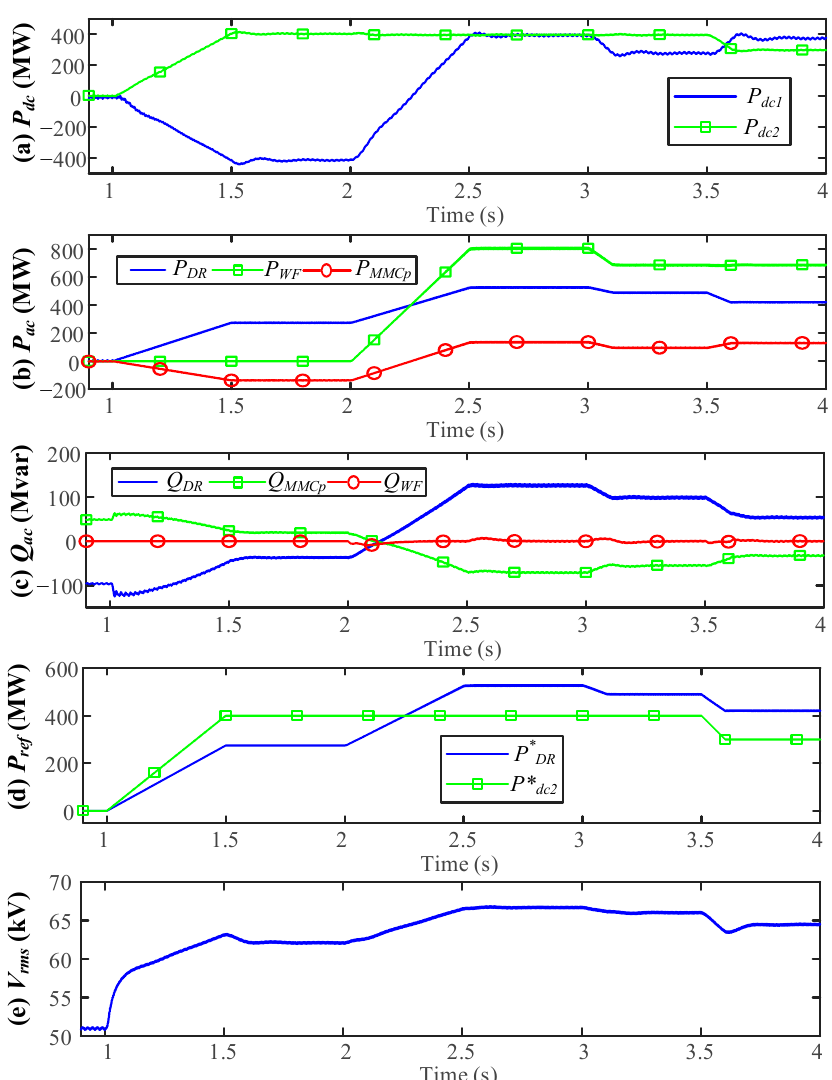
Figure 6. System operation in P-V ac control mode: ( a ) DC power; ( b ) Active power; ( c ) Reactive power; ( d ) Power reference; ( e ) RMS AC voltage.